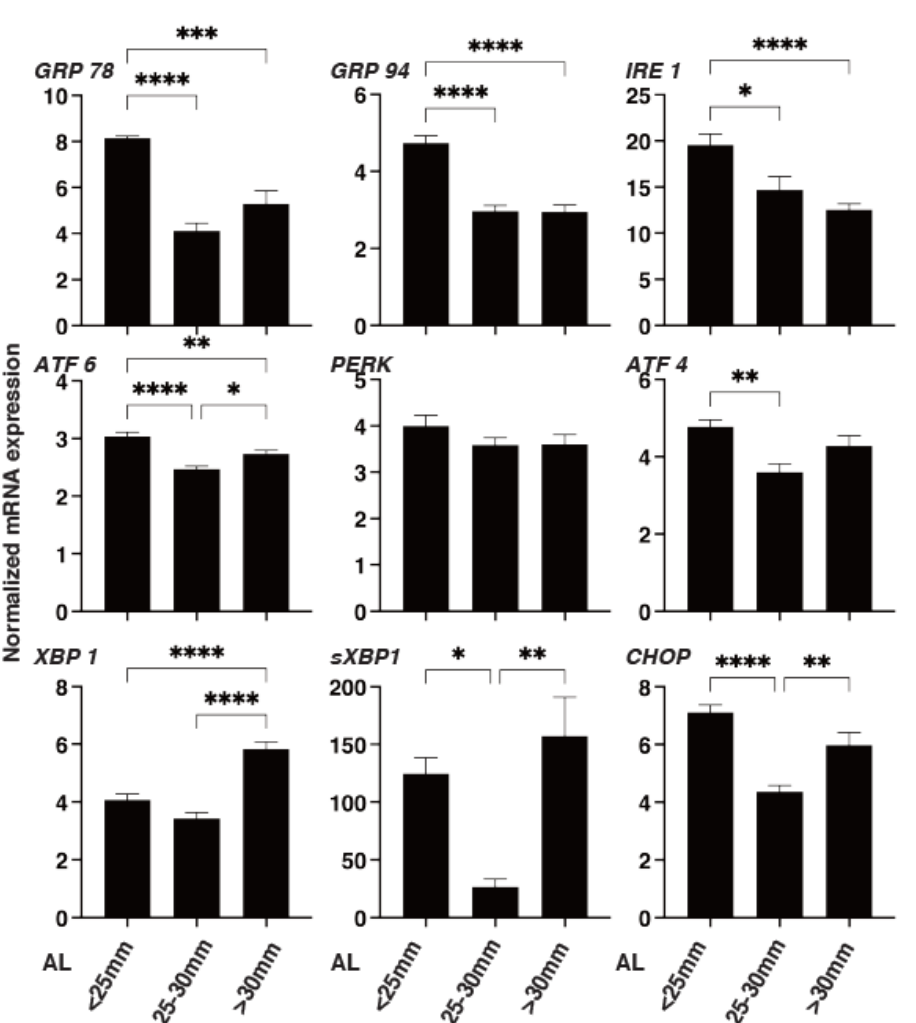
mm, 25–30 mm, or >30 mm of 3D spheroids of HSSFs were subjected to qPCR analysis at Day 5 and the mRNA expression of HIF 1A , HIF 2A , LOX ( panel A ), TIMP 1–4 ( panel B ), and MMP 2, 3, 9, and 14 ( panel C ) was estimated. No evidence for the expression of MMP9 was found. All experiments were performed in duplicate using fresh preparations ( n = 5, each). Data are presented as the arith- metic mean ± standard error of the mean (SEM). * p < 0.05, ** p < 0.01, **** p < 0.001 (ANOVA followed by Tukey’s multiple comparison test).